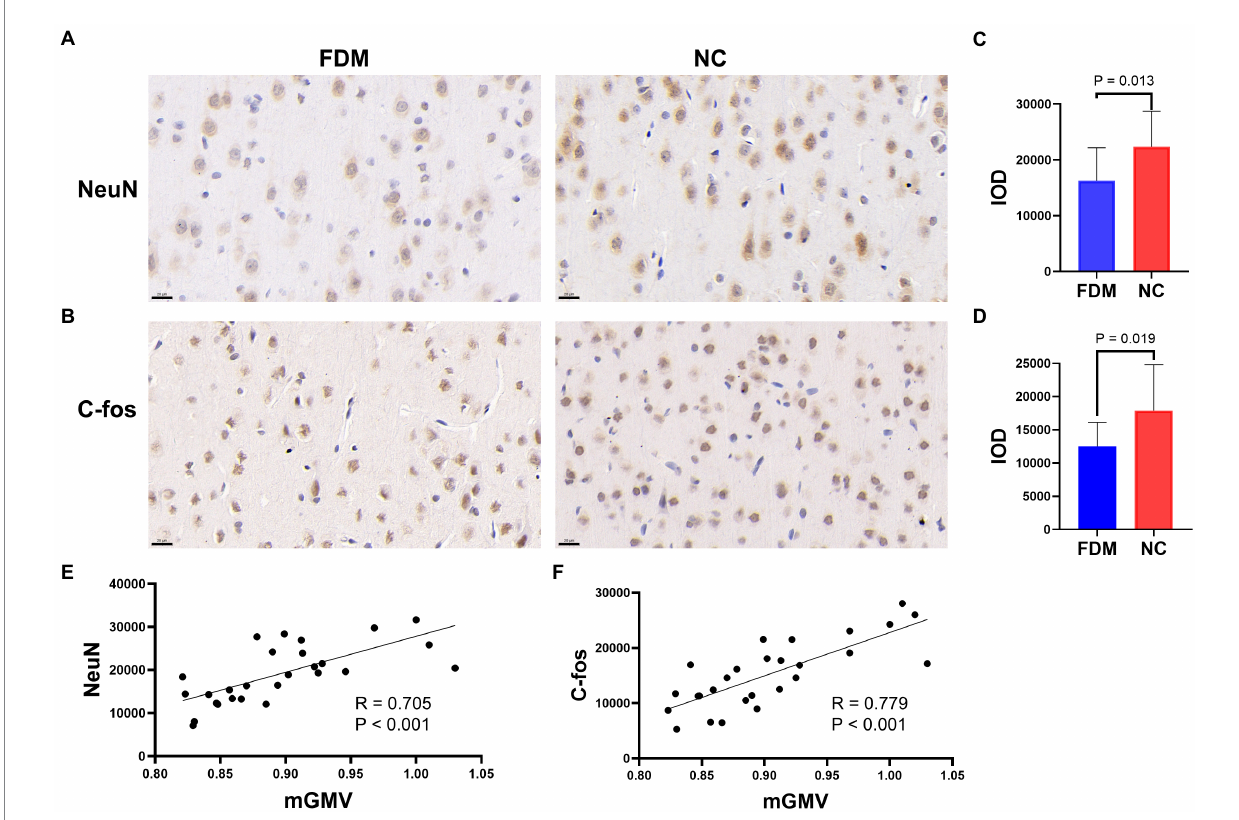
FIGURE 4 NeuN (A) and c-fos (B) expression in the tissues of visual cortex by immunohistochemistry in the FDM group and NC group (scale bar: 20 μ m). Histograms showing the IOD of NeuN (C) and c-fos (D) expression in the FDM group and NC group ( p < 0.05). Plot of the significant correlation between IOD of NeuN expression and mGMV of visual cortex (E) . Plot of the significant correlation between IOD of c-fos expression and mGMV of visual cortex (F) . NC, normal control; FDM, form-deprivation myopia; mGMV, mean gray matter volume; IOD, integrated optical